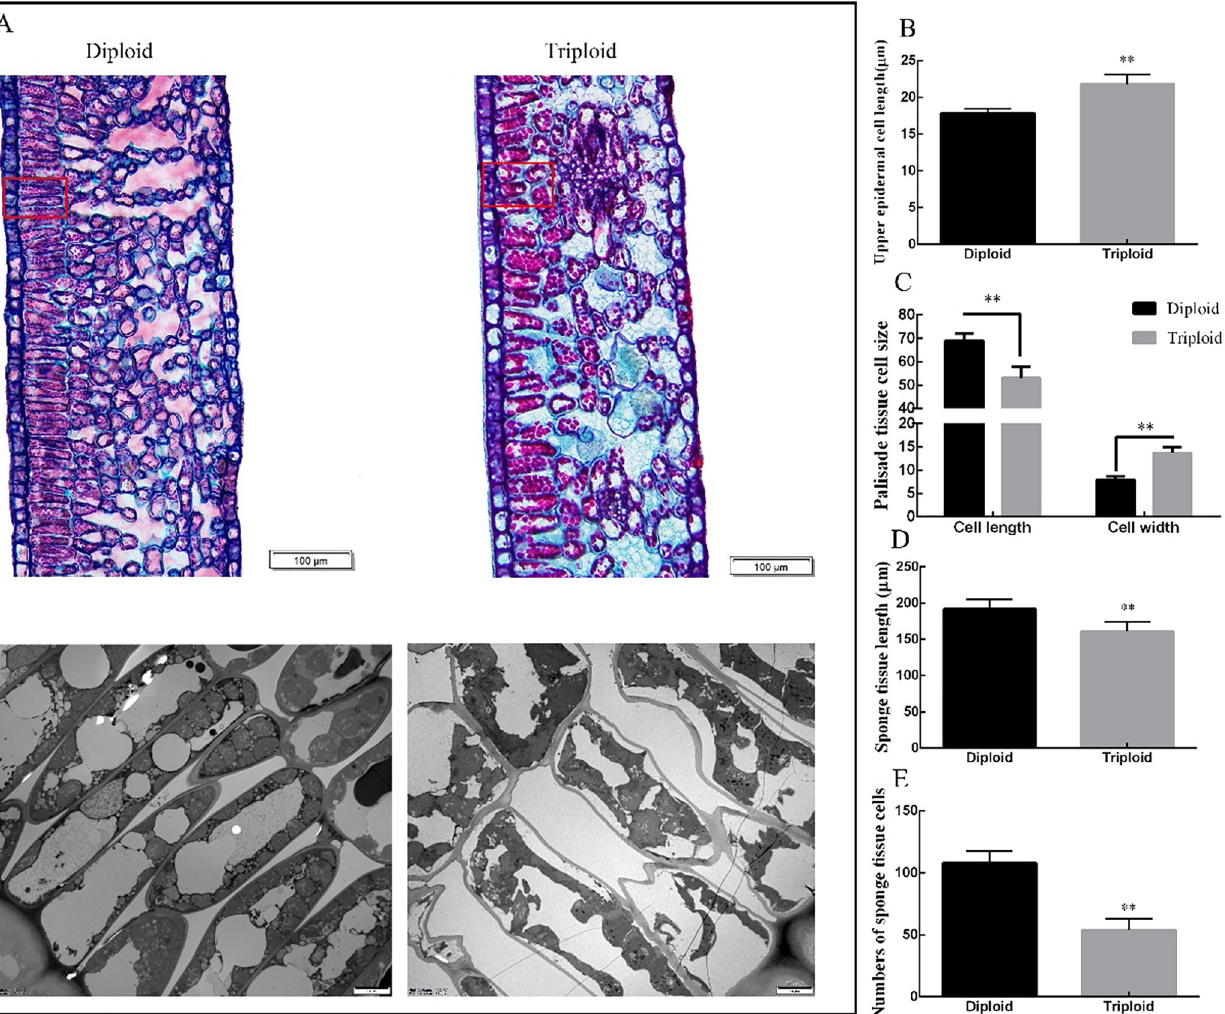
Fig 3. Transverse section of tea diploid and triploid leaf mesophyll. A: Diploid and triploid mesophyll cross sections under 100X magnification. B-E: Cross sectional length of upper epidermal cell, size of the palisade tissue cell, number of sponge tissue cells and sponge tissue length. Error bars indicate SD (n = 3); �� indicates significant difference at the 0.01 level between the diploid and